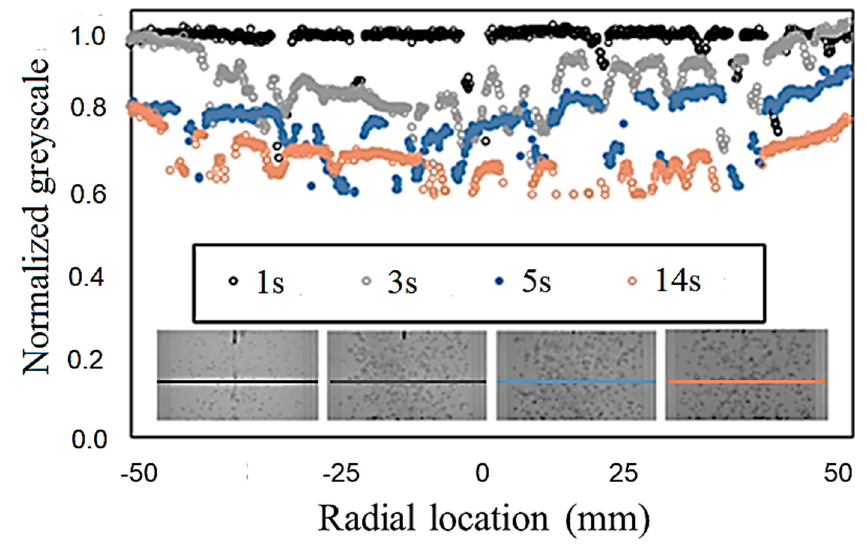
Figure 4. Grayscale measurement for evaluation of the temporal evolution of the dye concentration in bubble mixing.